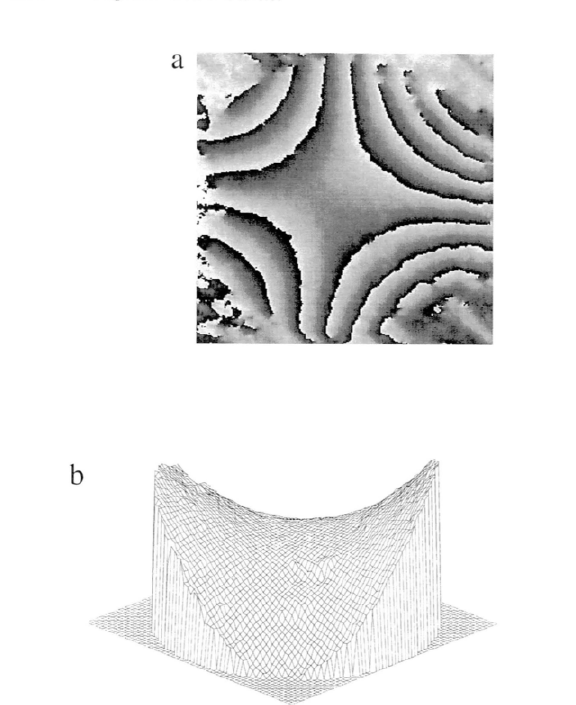
FIGURE 12 Plate vibrating with a frequency of 1297 Hz. pulse separation 150 J.LS: (a) phase map and (b) pseudo-3-D representation of the deformation. Fig. II (b), with a lens located in front of the cam era that magnifies the interfe rence pattern 6